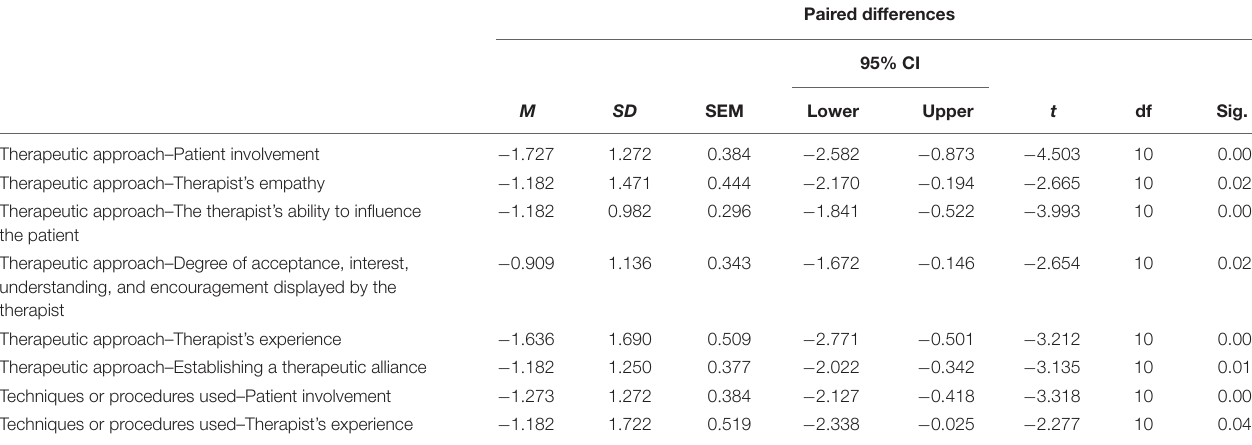
TABLE 4 | Paired samples t -test between the variable “Therapeutic approach” and “Techniques and procedures used,” and the rest of the common variables in eclectic-oriented therapists.